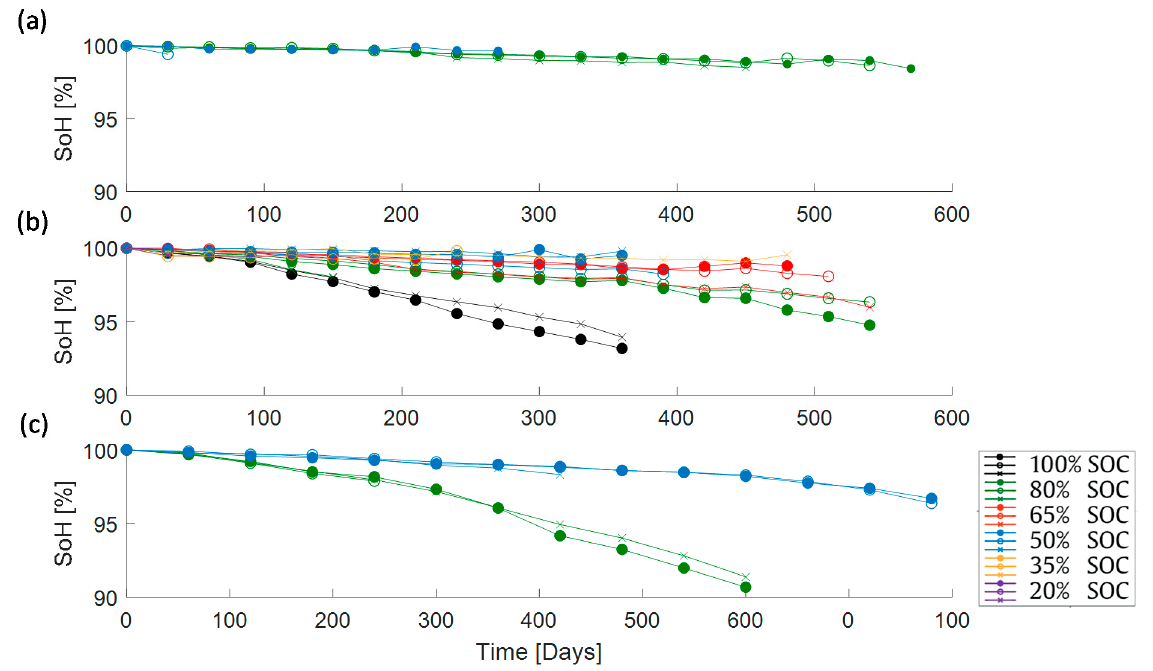
Figure 1. NMC normalised capacity after the data processing stage. Tests at ( a ) 25 °C, ( b ) 35 °C and ( c ) 45 °C.